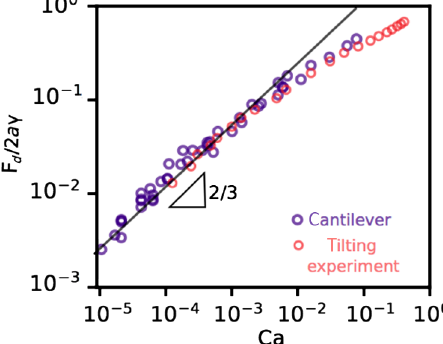
FIG. 9. Comparison between the force measurements per- formed in our previous paper using a cantilever force sensor (purple circles) [18] and the tilting experiments performed by Keiser et al. (red circles) [31].